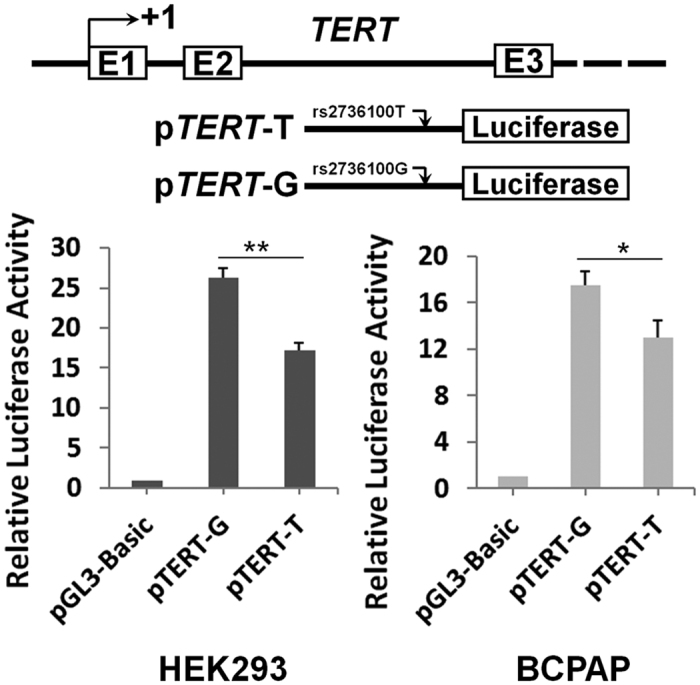
Transient luciferase reporter gene expression assays with constructs containing different rs2736100 allele of the TERT intron 2 region in HEK293 cells (A) or BCPAP cells (B). pRL-SV40 were cotransfected with these contructs to standardize transfection efficiency. Fold-changes were detected by defining the luciferase activity of cells co-transfected with pGL3-basic as 1. All experiments were performed in triplicates in three independent transfection experiments and each value represents mean ± SD. Compared with pGL3-Basic transfected cells, *P < 0.05; **P < 0.01.